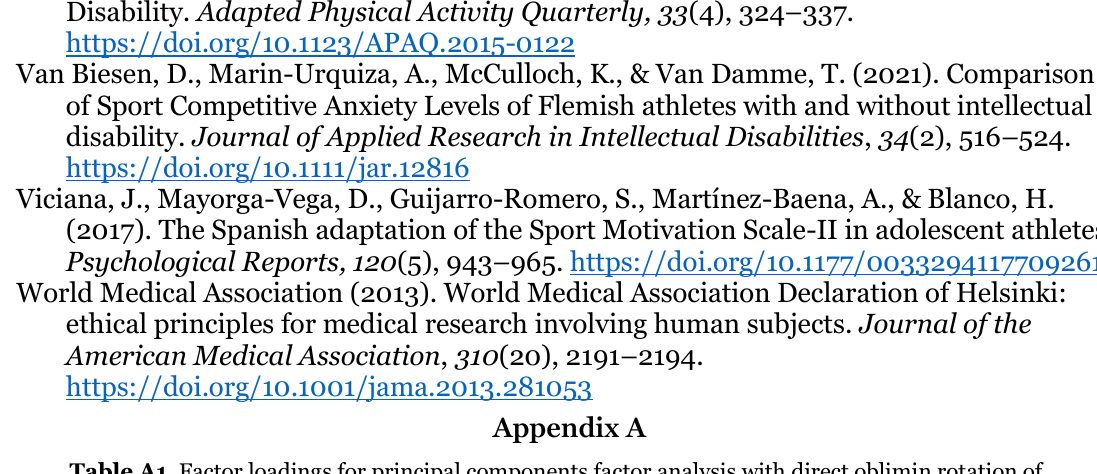
Table A1 . Factor loadings for principal components factor analysis with direct oblimin rotation of items of the three developed